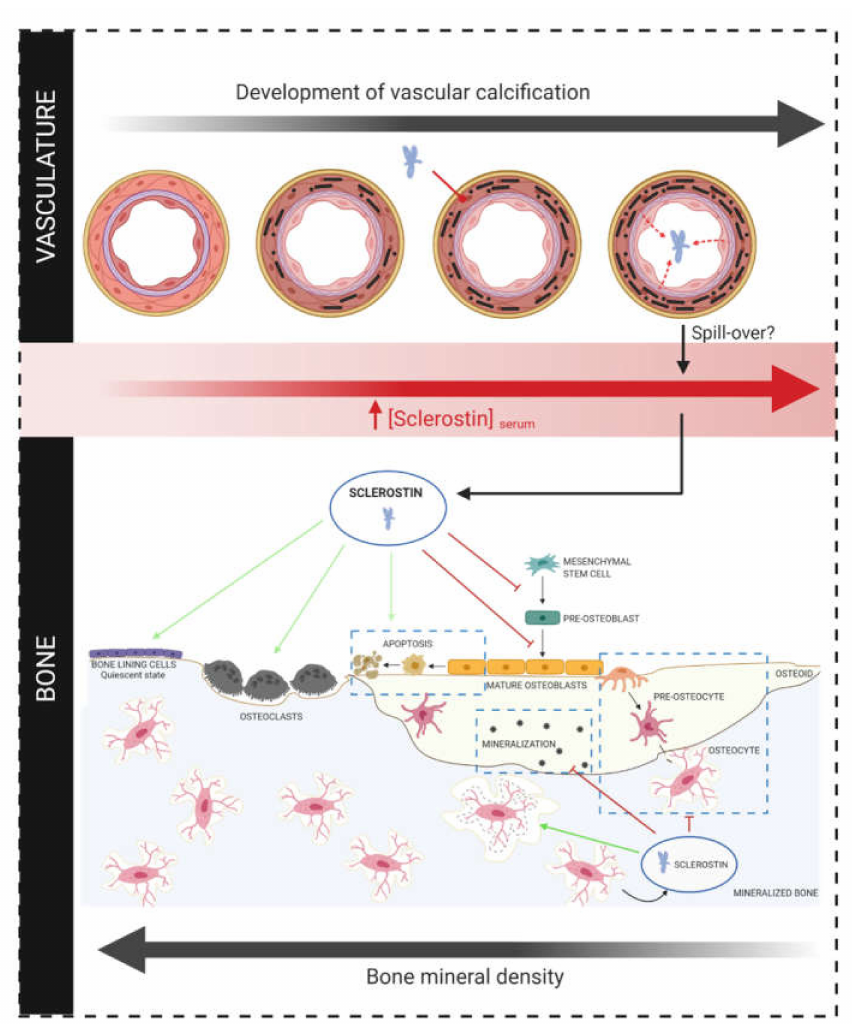
Figure 3. Hypothesized contribution of sclerostin in the calcification paradox. In a calcified artery, sclerostin is produced by transdifferentiated vascular smooth muscle cells [87,108]. It is hypothesized that this locally produced sclerostin can spill-over into the circulation, thereby contributing to increased serum sclerostin levels [87,134]. Via the circulation, this increased amount of sclerostin reaches the bone compartment,whereitmightbeinvolvedintheinhibitionofboneformation / mineralization /